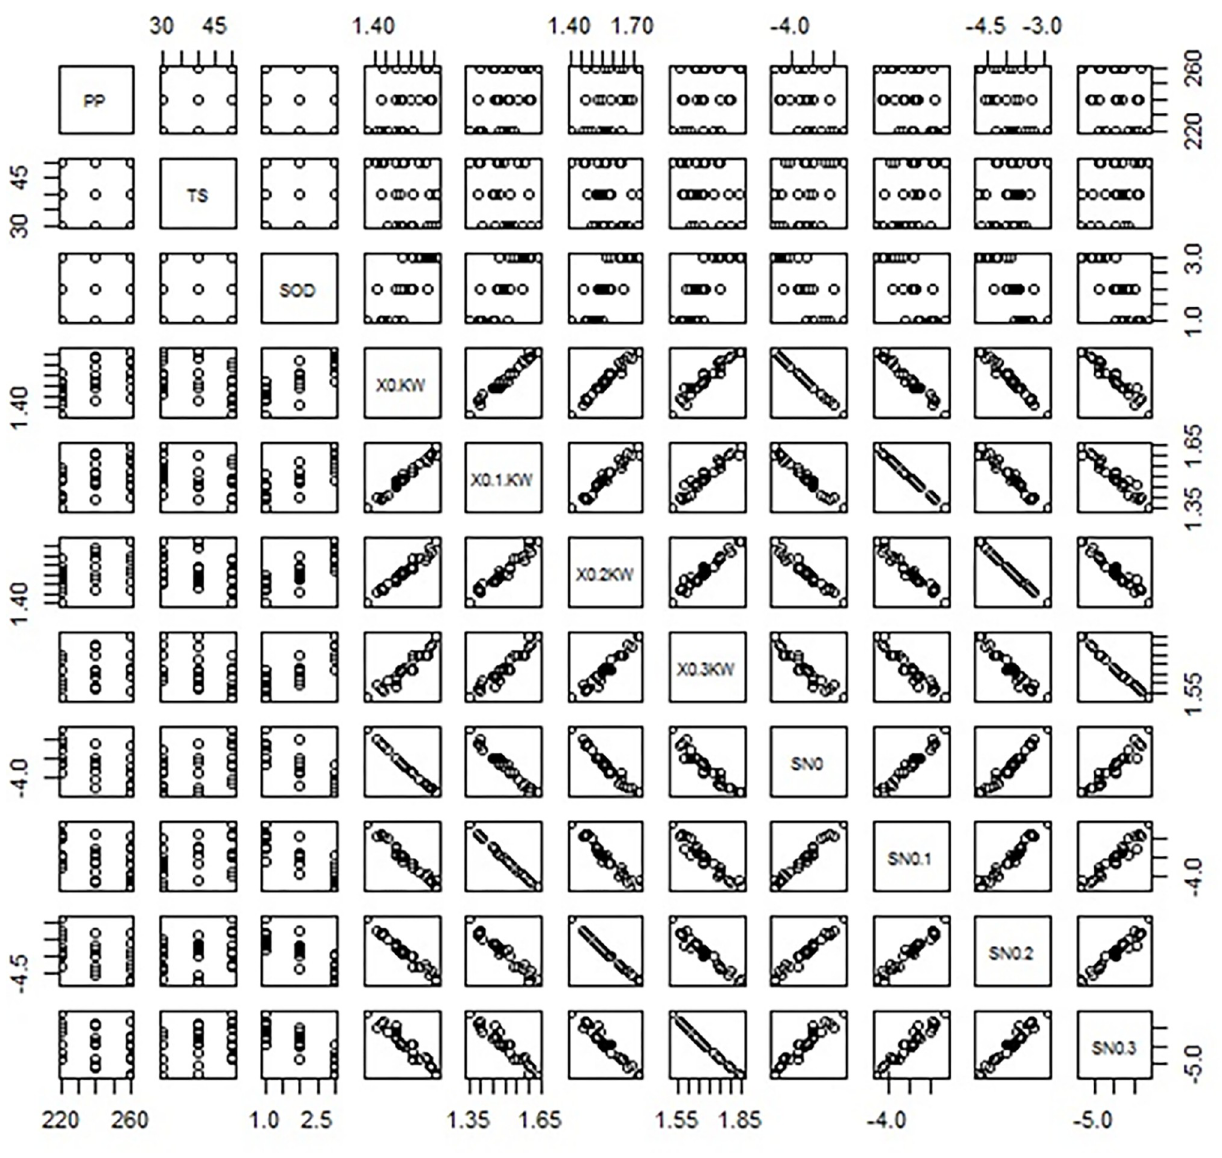
Fig 3. Matrix scatterplot of L27 OA